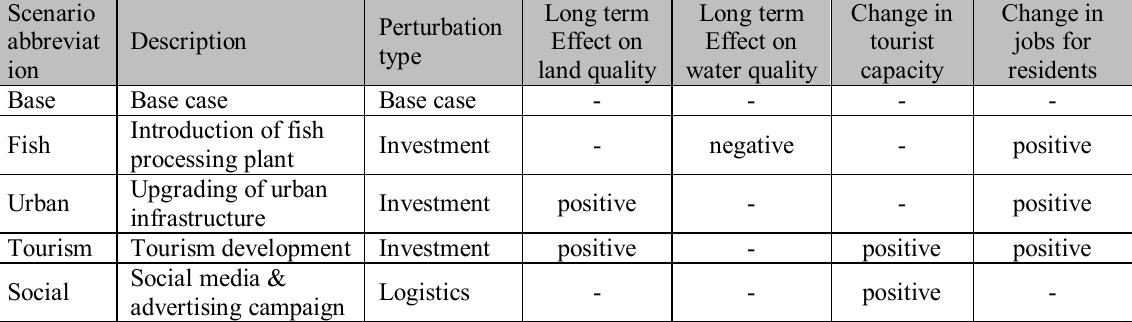
Table A1.4: Details of the direct influences (response connections) for four scenarios, the base case and three perturbation